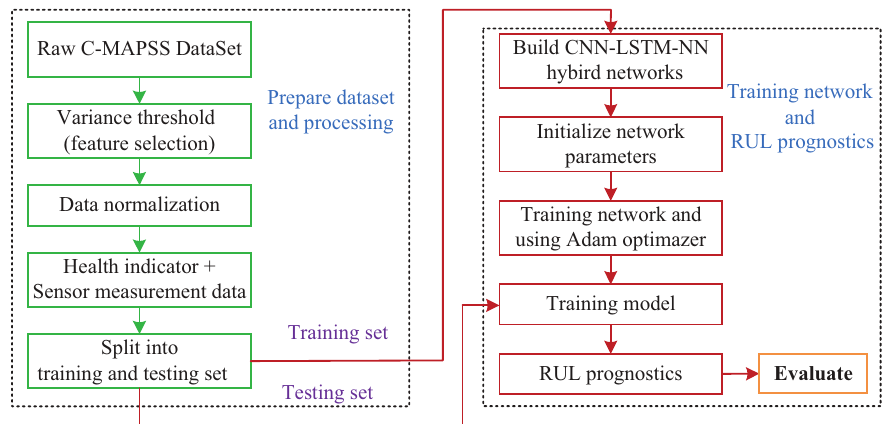
Figure 8. Flowchart of the proposed scheme.